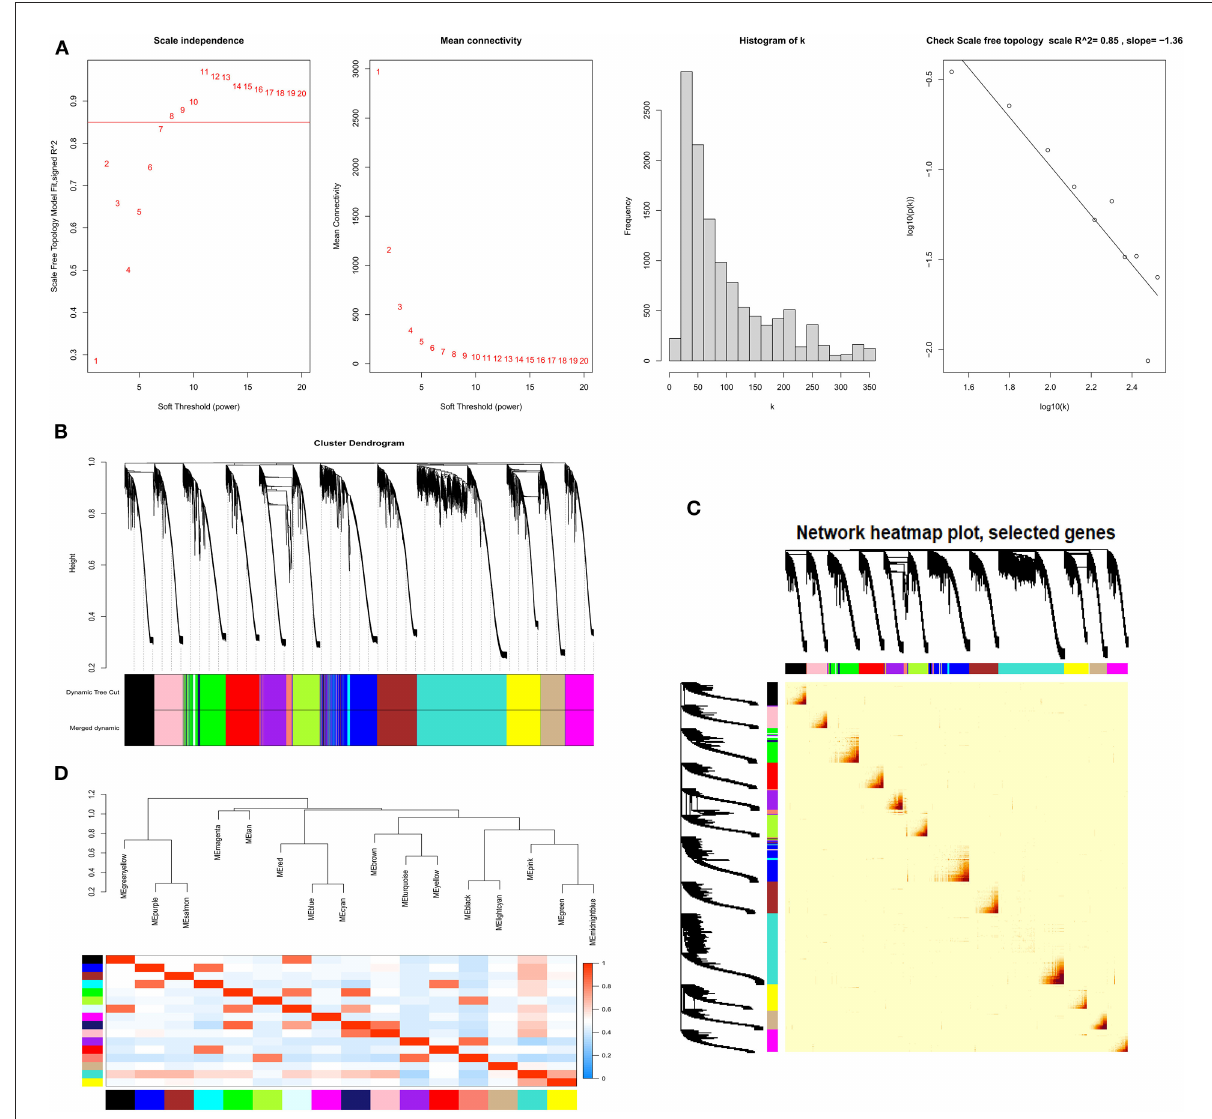
FIGURE7 The process of screening follicular development LncRNAs using WGCNA. (A) Selecting for soft threshold (power). When the power value is 8, the degree of independence was > 0.85 for the first time. (B) A Clustering dendrogram of genes. Dissimilarity was based on the topological overlap, together with assigned module colors. The 17 coexpression modules are displayed in different colors. (C) Heat map of the intergenic topological overlap matrix (TOM) based on co-expression modules. A redder background indicates a higher module correlation. (D) Visualization of gene networks using heat